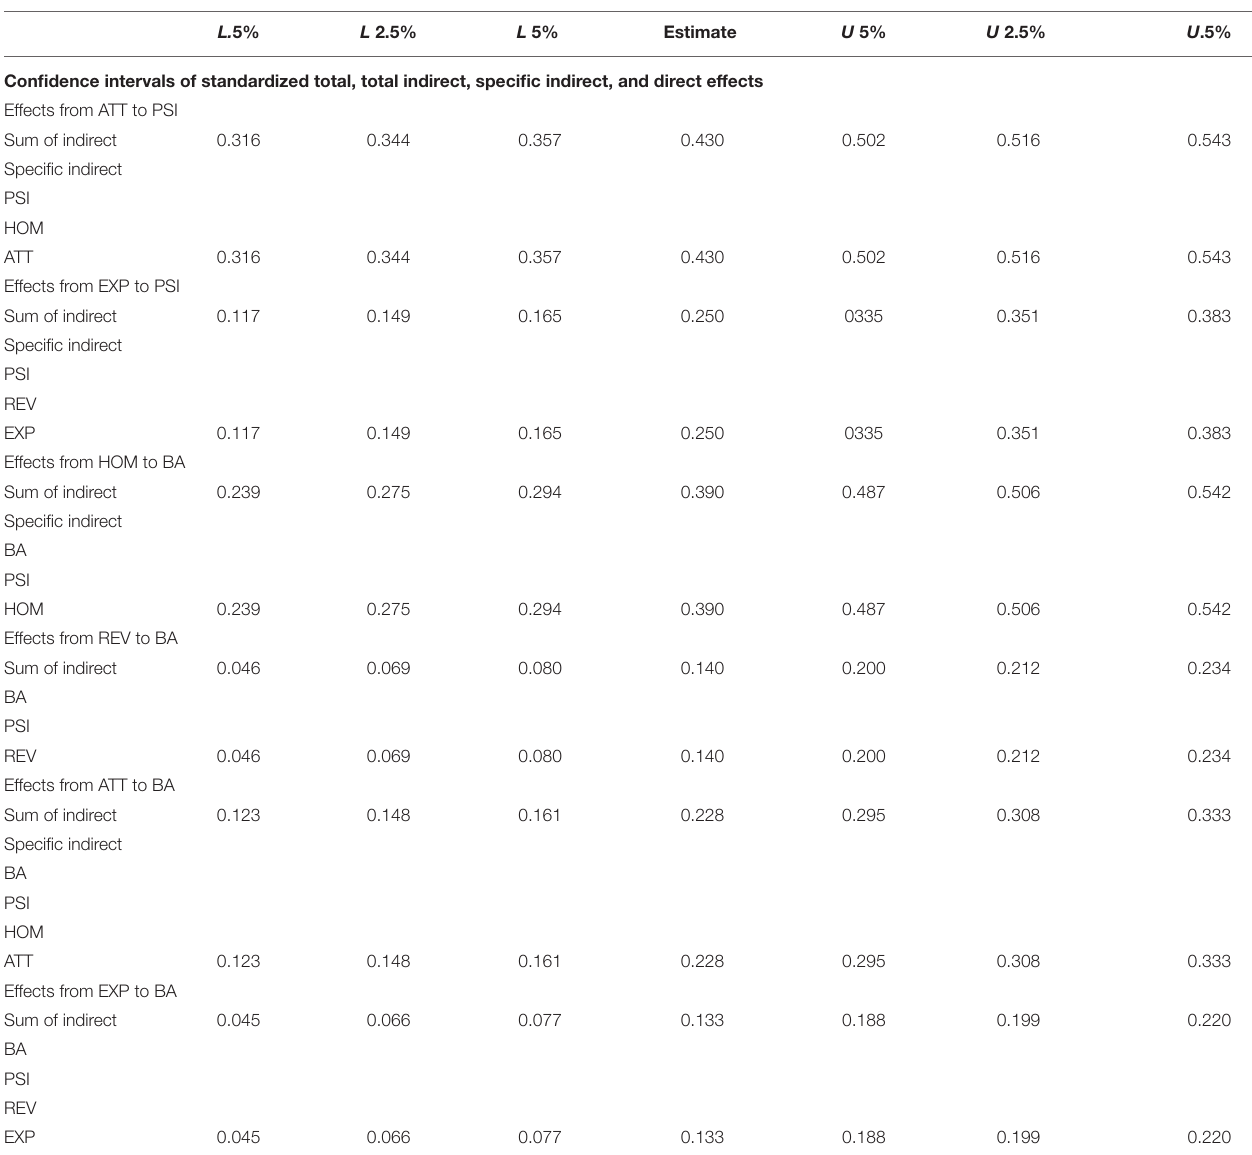
TABLE 4 | Output file of confidence intervals of standardized mediation